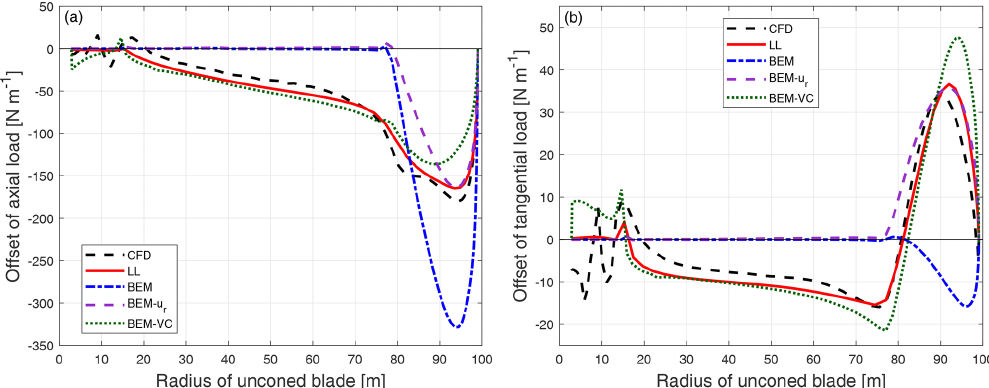
Figure B5. Comparison of the difference of the axial load (a) and tangential load (b) of the dihedral blade W-3 with 15 ◦ of cone upwind compared to the baseline blade with the same cone calculated from different aerodynamic models.